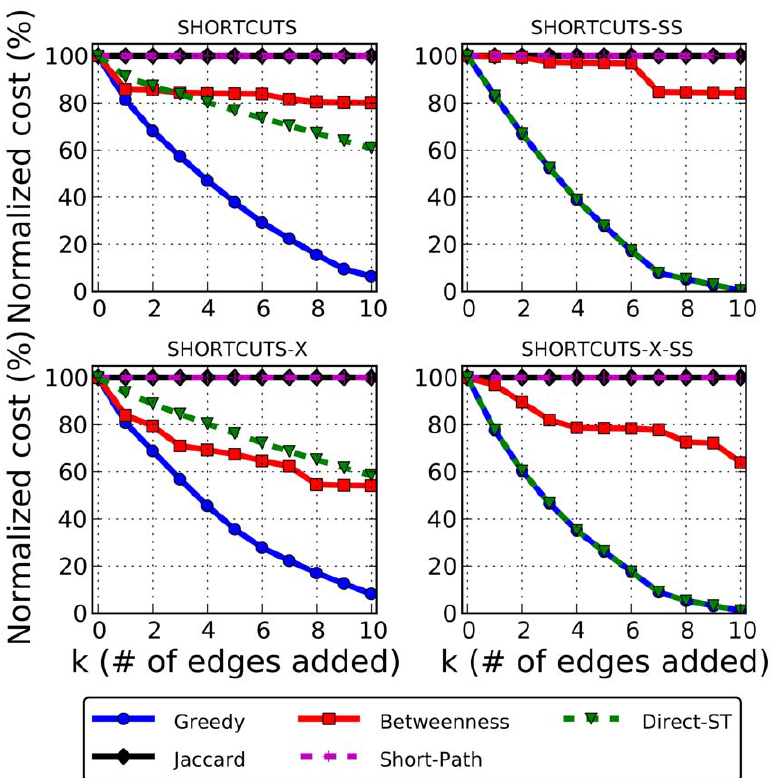
Figure 2. The cost reduction achieved by the five methods for each objective function. The x { axis shows the number of edges added, and the y { axis shows the new objective function cost as a percent of the original cost. Each new edge was added with weight 0.0. For S HORTCUTS and S HORTCUTS -X, Greedy significantly outperforms all other methods. For S HORTCUTS -SS and S HORTCUTS -X-SS, both Greedy and Direct-ST perform equally. As expected, the global methods (Jaccard and Short-Path) select HOG-independent edges that do not reduce any source-target distances.